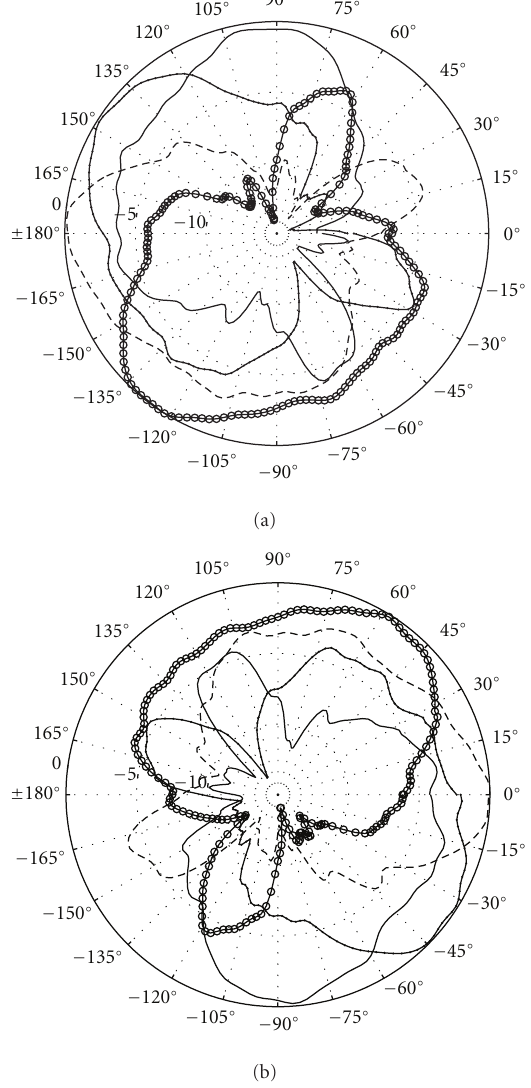
Figure 10: Simulated switched mode beams overlayed for the v- shaped antenna (a) elements 1 to 4 and (b) elements 5 to 8. Solid (elements 1 and 5), dots (elements 2 and 6), dashes (elements 3 and 7), and circles (elements 4 and